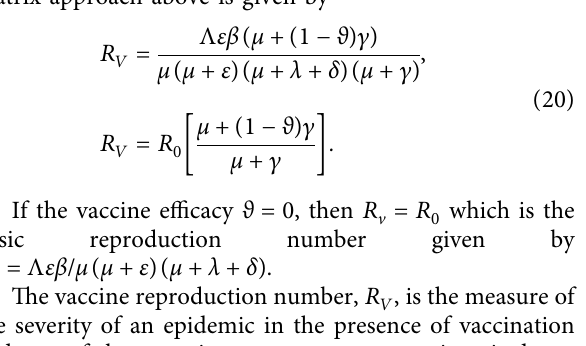
V with respect to the model